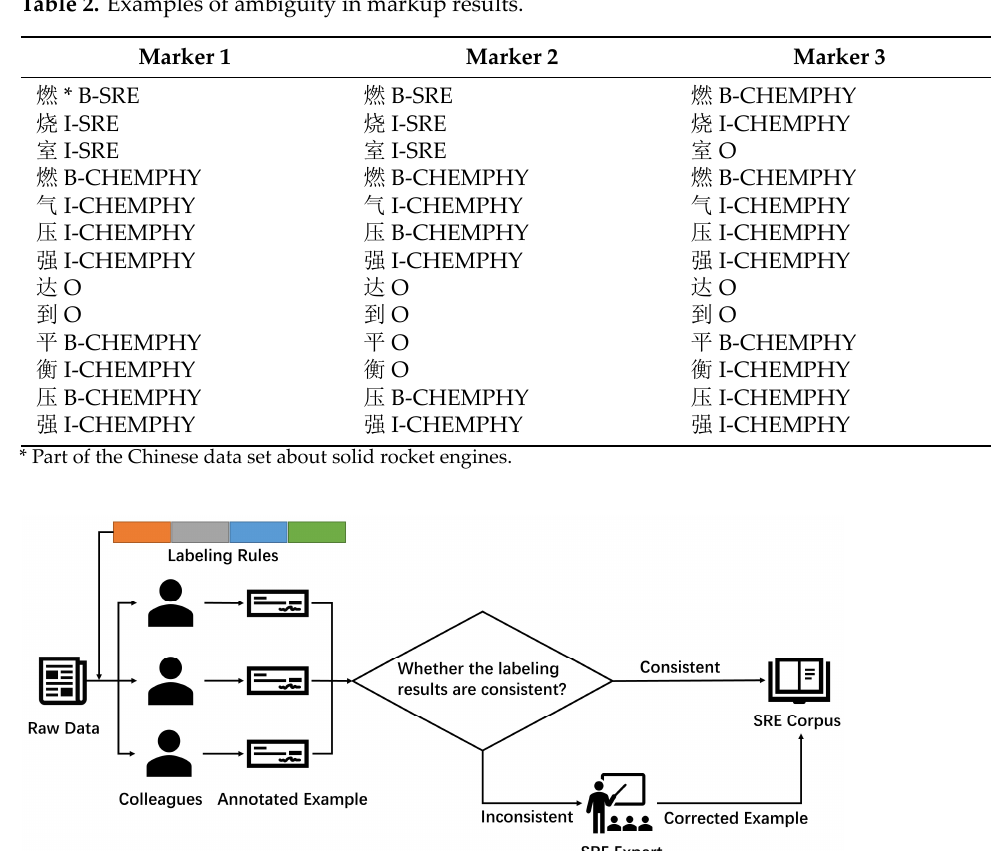
Table 2. Examples of ambiguity in markup results.